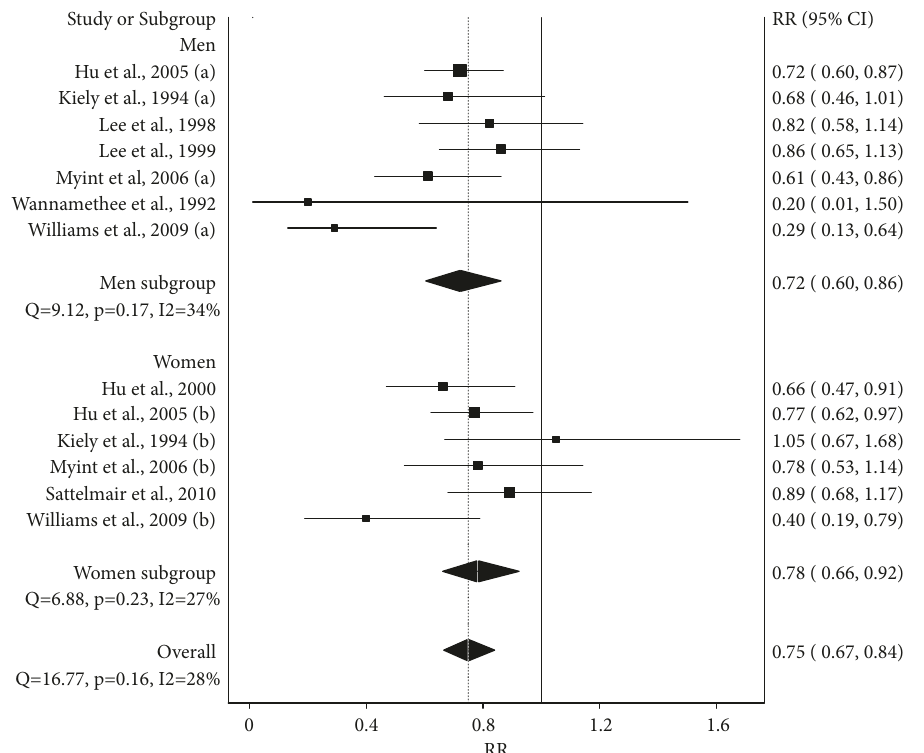
Figure 2: Forest plot for association between high versus low leisure time physical activity and the relative risk of fatal or nonfatal stroke (hemorrhagic or ischemic) using the IVhet model. The black squares represent the relative risks (RR) while the left and right extremes of the squares representthe corresponding 95% confidence intervals for the RR. The middle of the black diamonds represents the RR while the right and left extremes of the diamond represent the corresponding 95% confidence